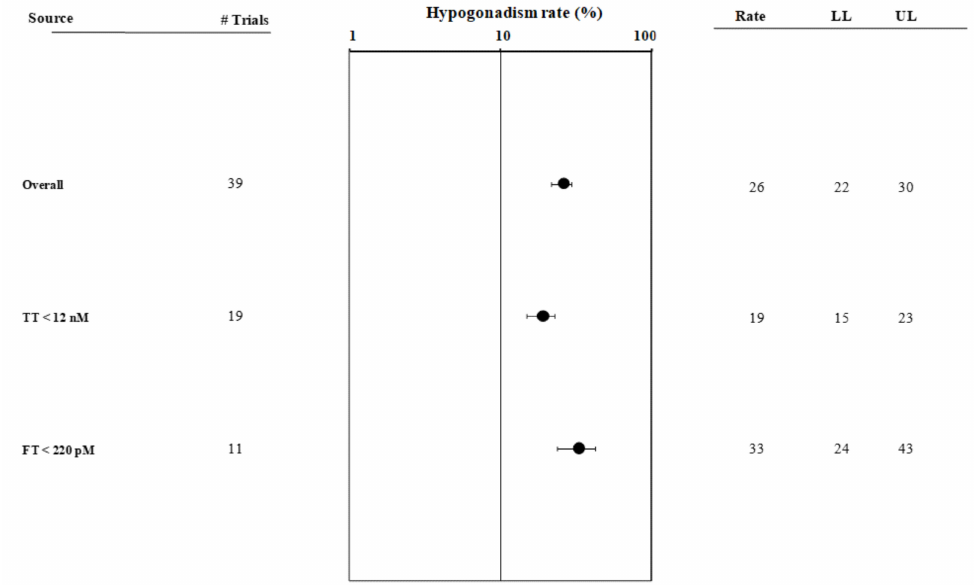
Figure 2. Forest plot showing hypogonadism prevalence in studies detected in the first literature search. fT: free testosterone; LL: lower limit; UL: upper limit; TT: total testosterone.